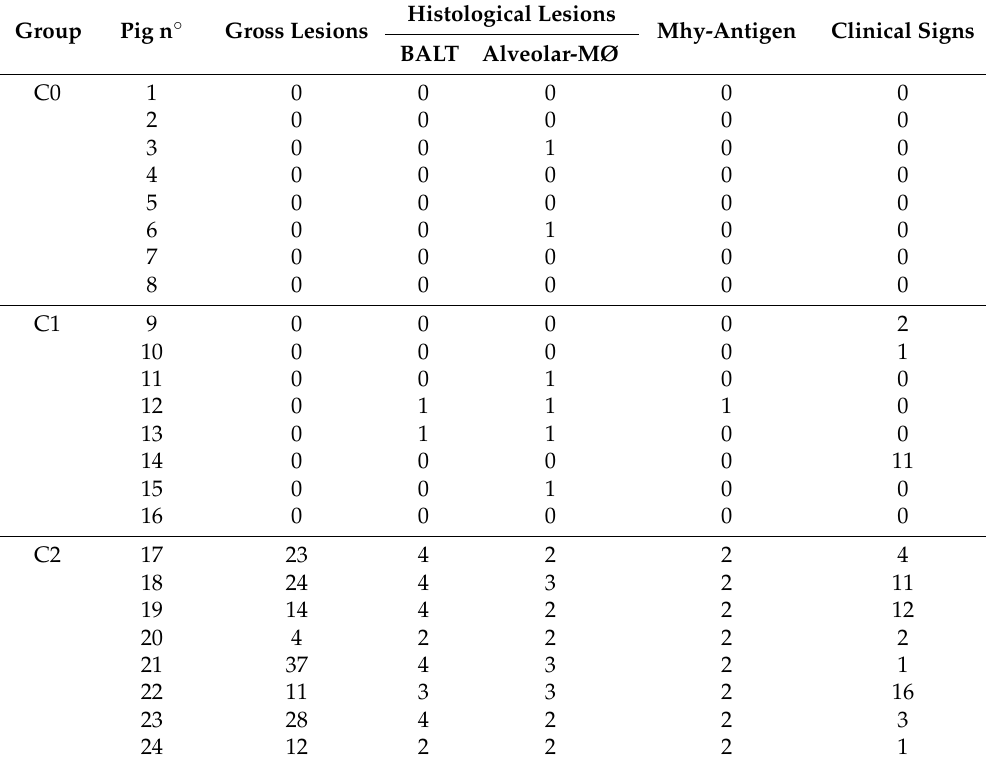
Table 1. Gross, histological, immunohistological and clinical findings in controls and Mhy-infected pigs. Histological Lesions Group Pig n ◦ Gross Lesions Mhy-Antigen Clinical Signs BALT